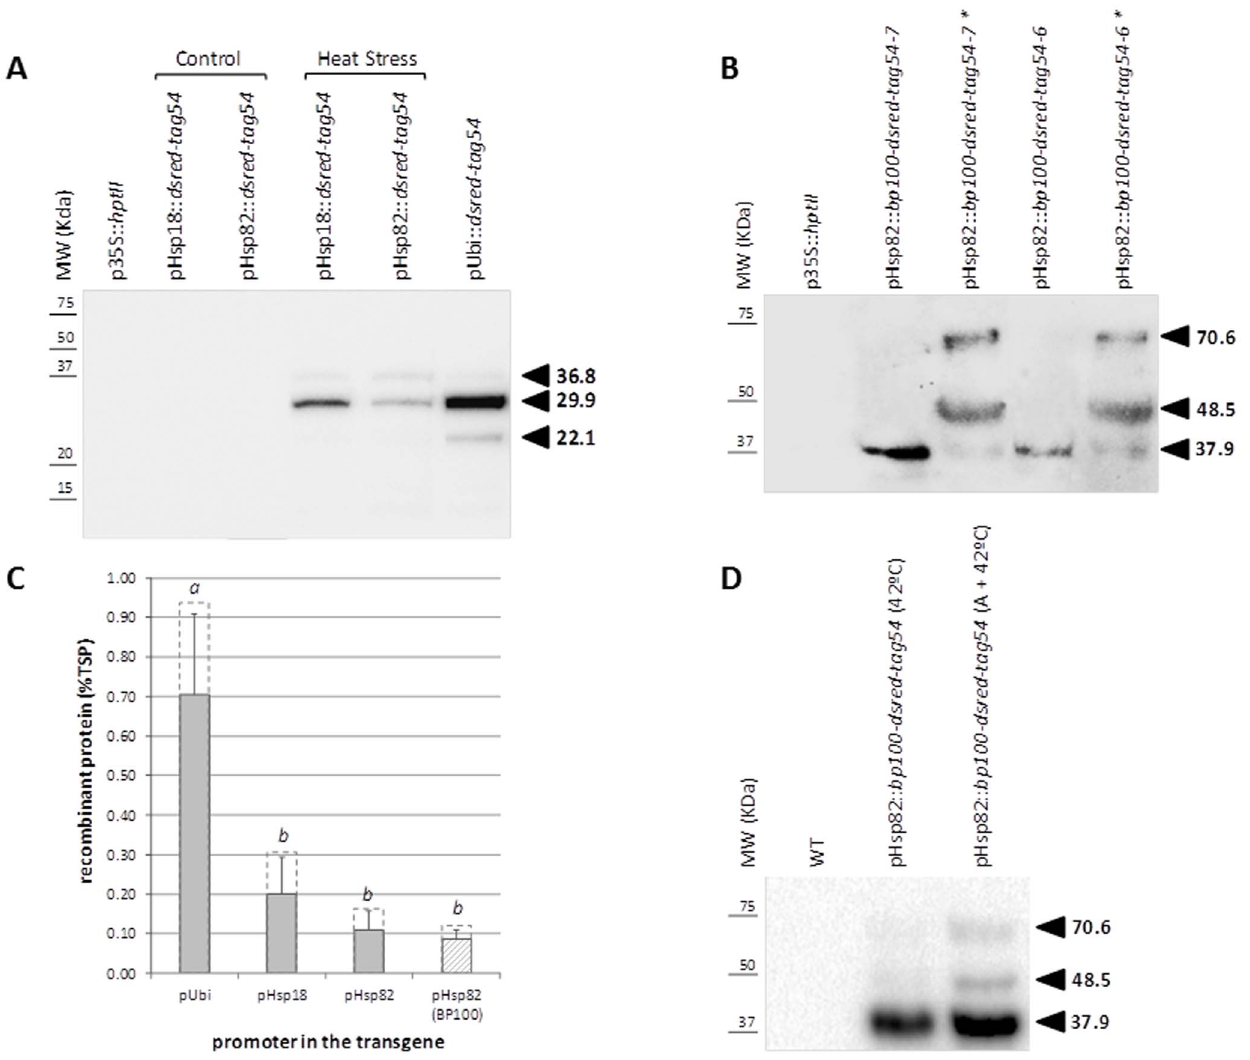
Figure 7. Recombinant DsRed-tag54 and BP100-DsRed-tag54 accumulation in transgenic rice seedlings. Western blot analysis of proteins from GM plants carrying: ( A ) p35S:: hptII , pUbi:: dsred-tag54 , pHsp18:: dsred-tag54 and pHsp82:: dsred-tag54 , either treated at 42 u C (heat shock) or not (control); ( B ) pHsp82:: bp100 - dsred-tag54 (two independent events are shown) treated at 42 u C. Recombinant protein in TSP was extracted from rice seedlings (five plants per event) and 20 m g of TSP per lane was boiled for five minutes and separated by SDS-PAGE before transfer to nitrocellulose filters. In lanes marked with an asterisk, insoluble pHsp82:: bp100 - dsred-tag54 pellets were re-extracted in 8 M urea and 1% SDS buffer. Recombinant proteins were detected using the mAb54k antibody (diluted 1:1,500) and the horseradish peroxidase-labeled anti-mouse IgG secondary antibody (diluted 1:10,000) followed by ECL chemiluminescent detection. Five to 20 pmol of chemically synthesized controltag54 mixed with 20 m g TSP from wild type rice was used as standards for quantification. GM rice carrying p35S:: hptII was used as control. ( C ) Recombinant protein accumulation values. Means and SD of three independent events per construct are shown in filled boxes; letters indicate statistically different values; values corresponding to the highest producer event are shown in dashed boxes. ( D ) Western blot analysis of proteins from GM plants of a single event carrying pHsp82:: dsred-tag54 , either directly subjected to 42 u C or with a 6 h initial step of gradual temperature increase up to 42 u C (A + 42 u C) (five plants per condition). Recombinant proteins were extracted in 8 M urea and 1% SDS buffer. Senia (WT) was used as